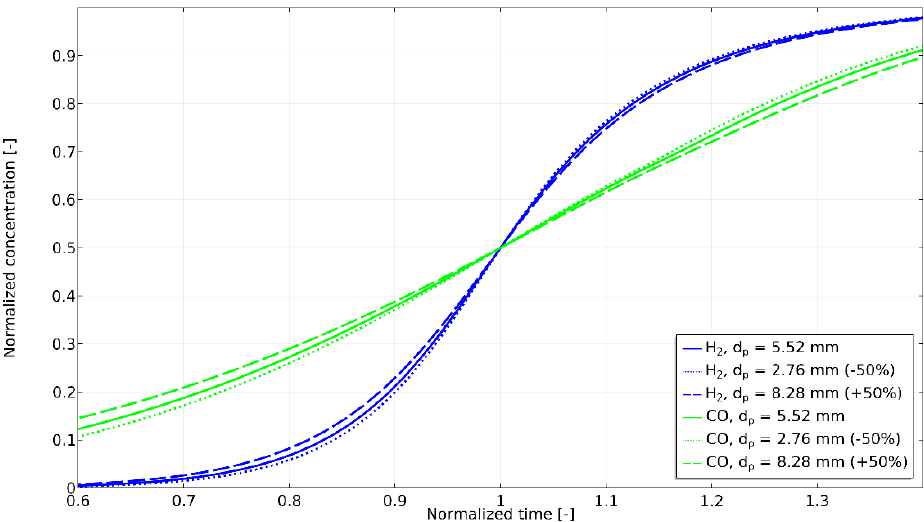
Figure 13. Mass transfer effects following a particle dimension sensitivity analysis during reduction with syngas.